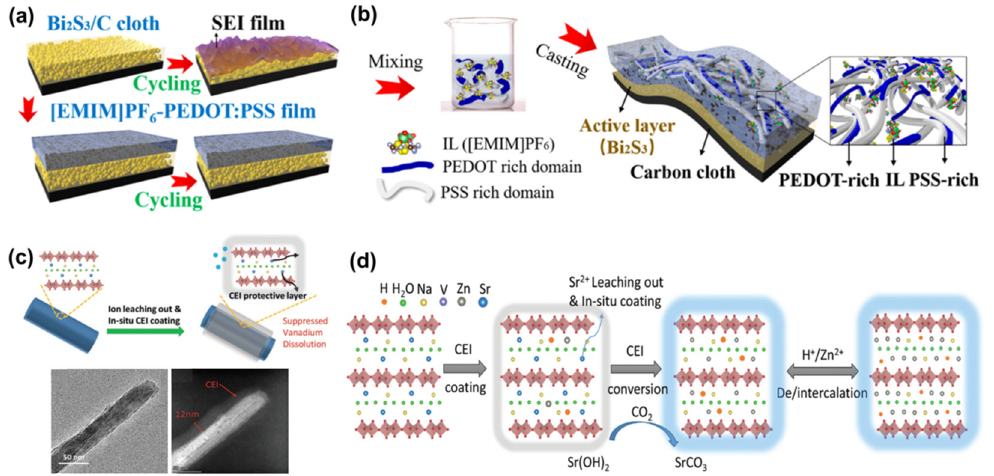
Figure 8. ( a ) Schematic illustration and ( b ) fabrication process of the [EMIM]PF 6 -PEDOT:PSS films. Reproduced with permission from [67]. ( c ) Schematic design principle and ( d ) working mechanism of the in situ CEI layer. Reproduced with permission from [68].